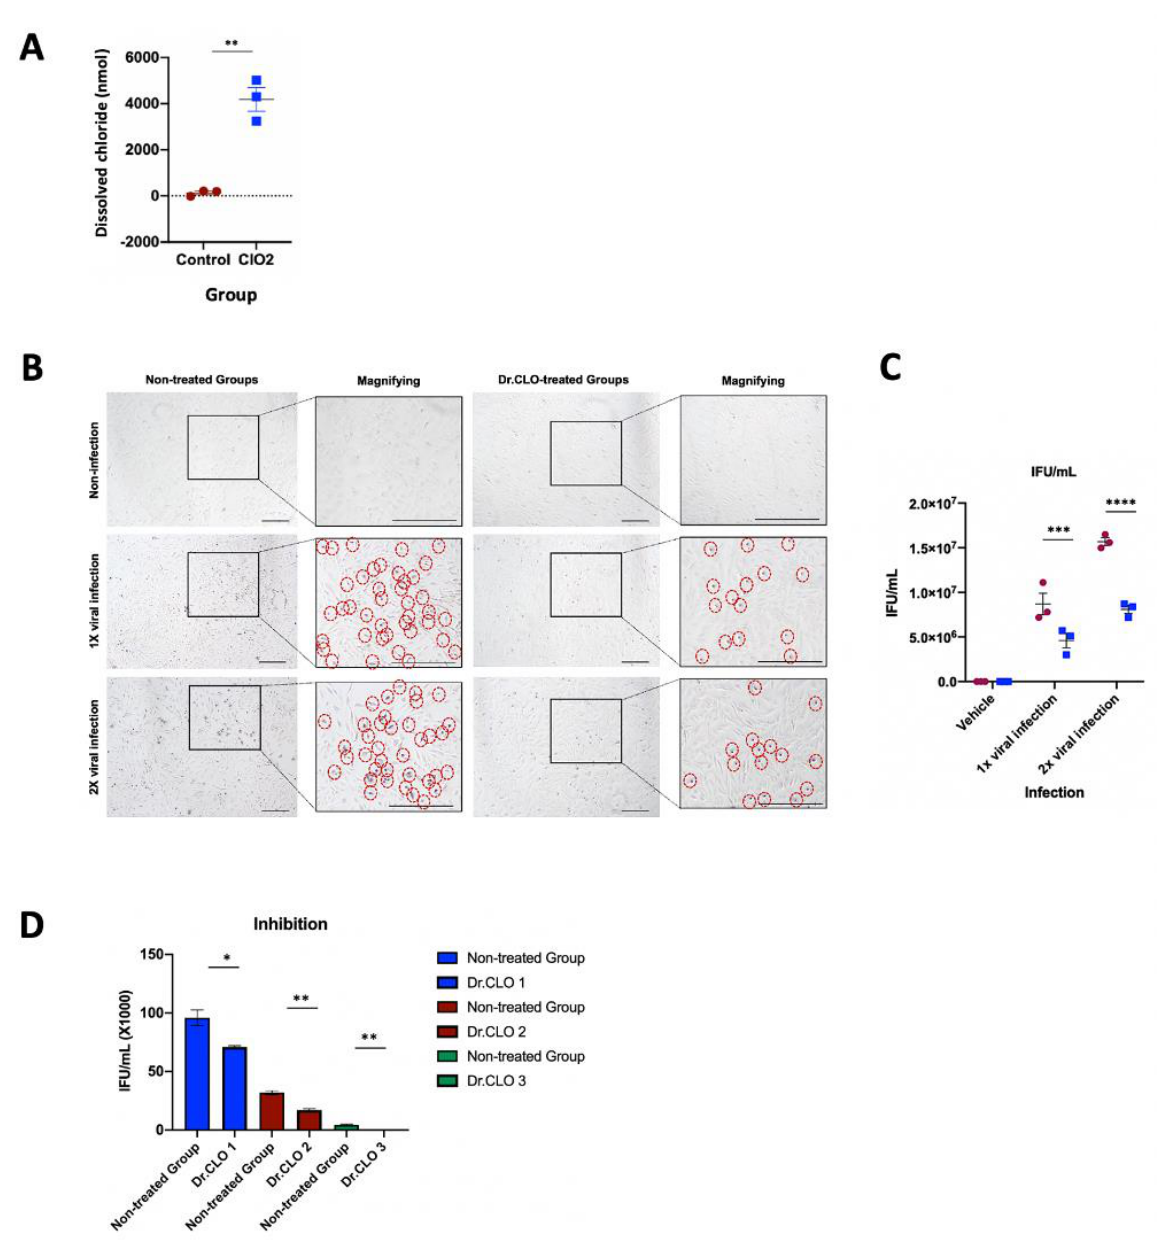
Figure 2. Quantitative and qualitative inhibitory effect of treatment by Dr.CLO TM on adenoviral amplification. ( A ) The dissolved chlorine concentration in cell culture medium after activation of Dr.CLO TM for 24 h. ( B ) When human bronchial epithelial (HBE) cells were inoculated with multiple adenovirus doses (1 × & 2 × ) using the immunocytochemistry (ICC) method, infected positive cells showed purple reactions. Infected cells are marked with red dotted circles. ( C ) Results of positive cells not treated with Dr.CLO TM and the number of positive cells inhibited when treated with Dr.CLO TM . Dr.CLO TM showed inhibitory effects on both 1 × and 2 × viral infections. ( D ) Adenoviral titers (IFUs/mL) inoculated randomly at three different concentrations were significantly reduced by Dr.CLO TM . The black square box represents the enlarged cell shape. The error bars indicate mean ± SEM; *, p < 0.05; **, p < 0.005; ***, p < 0.0005; ****, p <